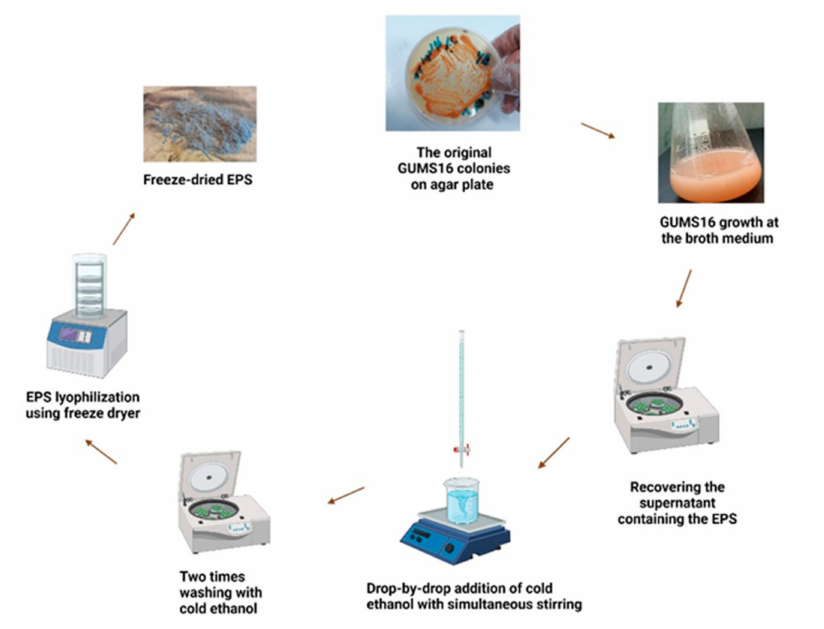
Figure 1. Exopolysaccharide extraction and recovery process from Rhodotorula mucilaginosa sp.